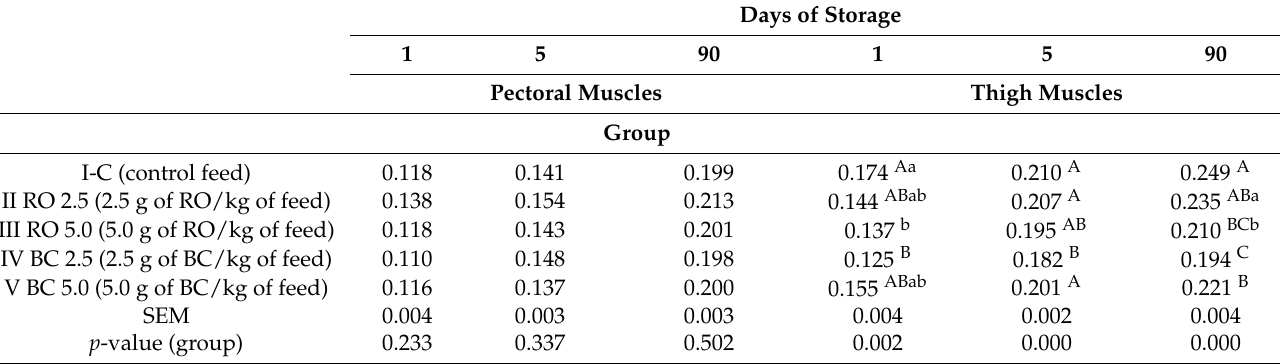
Table 5. TBA values, presented as MDA content [mg/kg] in breast and thigh muscles stored at 2–3 ◦ C for 1 and 5 d, or stored at − 18 ◦ C for 90